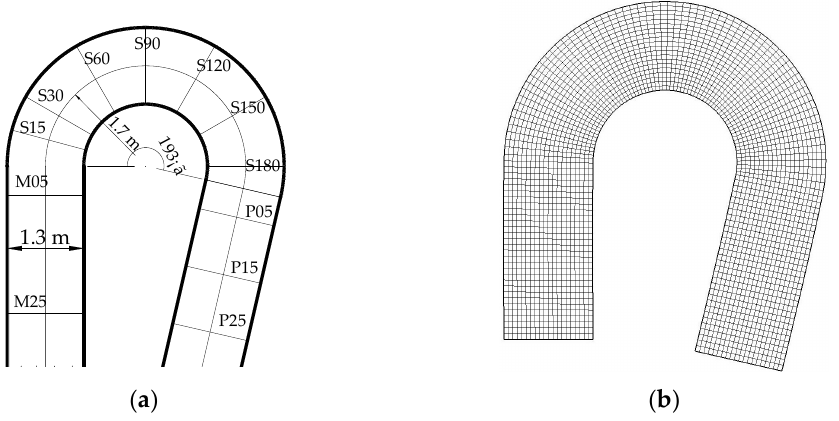
Figure 2. ( a ) Blanckaert (2002) experimental setup; ( b ) horizontal discretization of the calculation domain. The simulation was run on a staggered grid with 130 × 20 cells with inlet and outlet reaches both shortened to 2.6 m (Figure 2b). The calculation time step was 0.02 s. The water surface level was calculated at the outlet, using uniform flow conditions which employ the overall slope along the bend centerline. Fixed discharge (0.089 m 3 /s) was set at the upstream boundary. The resistance coefficient was set as 0.02 and no friction was considered in the simulation on the lateral walls for the sake of simplicity. The simulation was run on a computer with intel i7 3770 CPU and 4 GB RAM. Simulation for a duration of 400 s cost a CPU time of about 252 s, 1021 s, 2085 s, and 2877 s for N = 0, 2, 4, and 6 respectively. As N = 0 is the normal depth-averaged 2D model case, the model was effi- cient on the 2D model level. Here only the results of N = 2 are shown. Grid independency was tested on another grid with 130 × 40 cells. For the same experiment, van Balen et al. [39] previously ran the simulation using an LES-based approach on a grid with 1260 × 192 × 24 cells, and Zeng et al. [40] employed RANS with 127 × 101 × 35 cells. The computa- cell number.